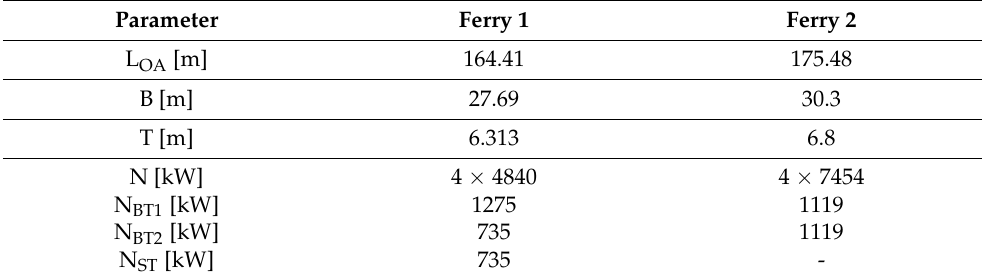
Table 2. Main particulars of the ferries.